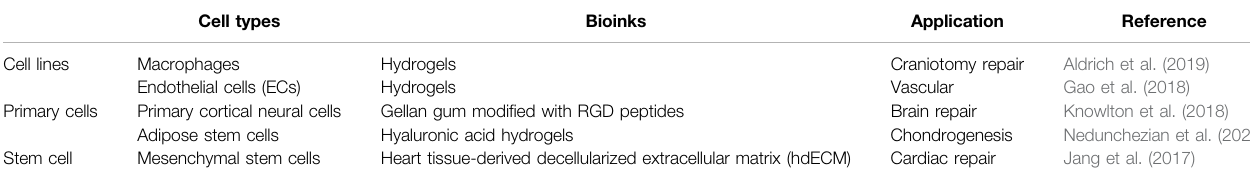
TABLE 1 | Different cell types for 3D